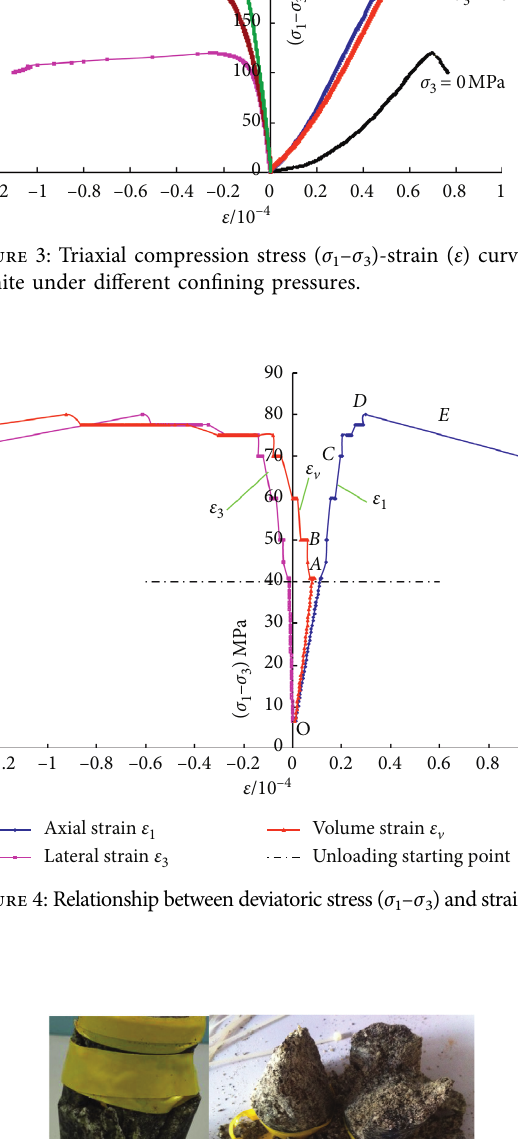
Figure 5: Macroscopic damage mode of granite.